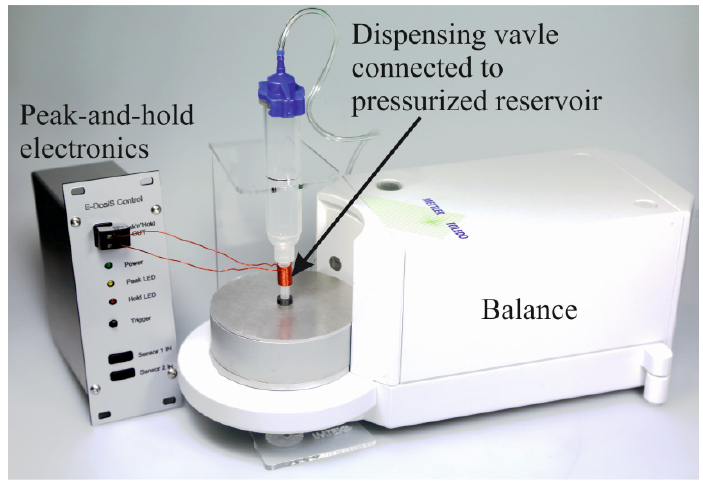
Figure 6. Measurement set-up to characterize the dosing performance of